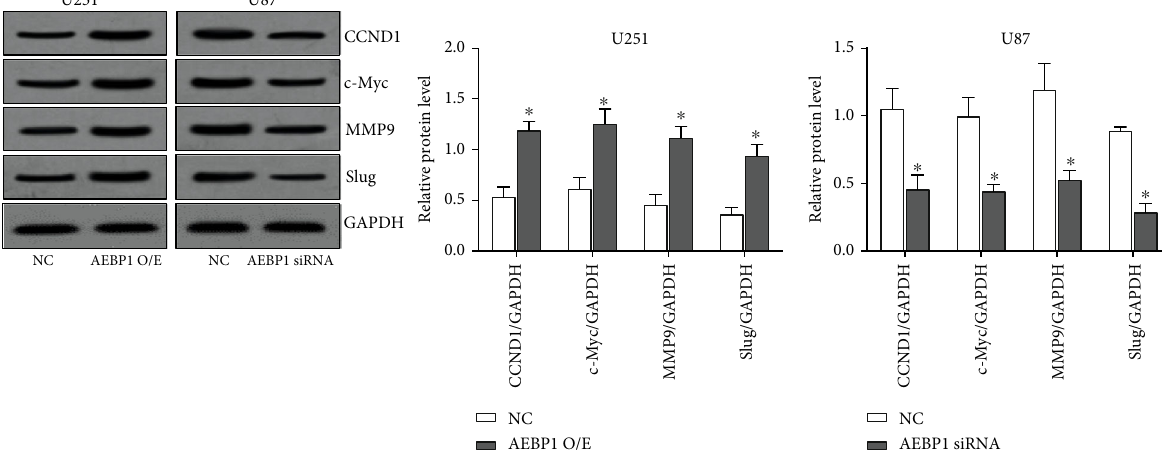
Figure 8: AEBP1 promotes the expression of CCND1 , c-Myc , MMP9 , and Slug in vivo. Western blot was used to detect the expression levels of CCND1 , c-Myc , MMP9 , and Slug in subcutaneous GBM xenografts formed in nude mice. N = 3 , ∗ P < 0 : 05